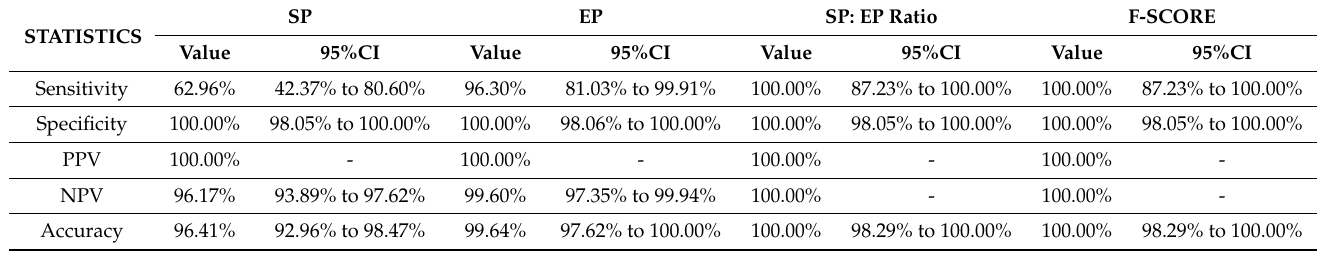
Table 1. Performance of PAD–Mi a using four different analysis criteria (SP, EP, SP: EP ratio, and F-score).